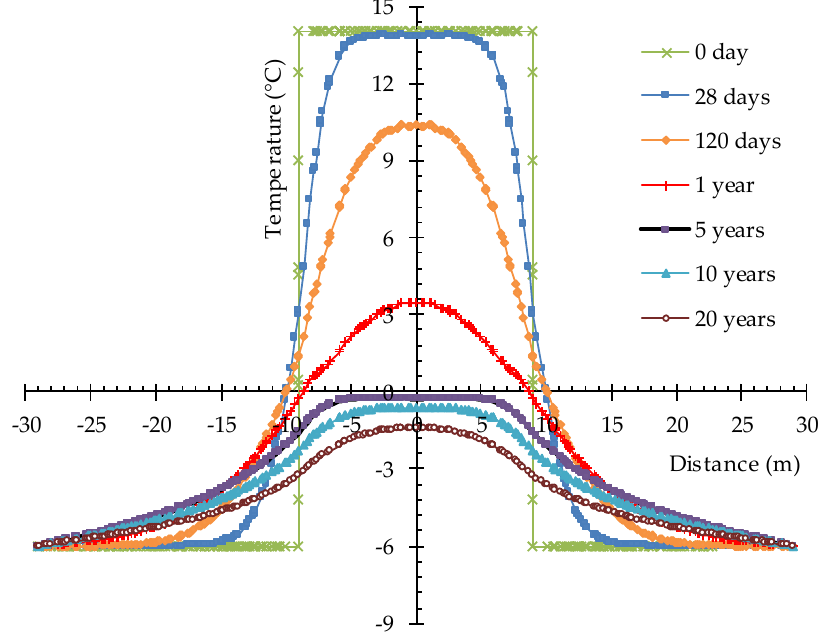
Figure 9. Transverse temperature distribution along the horizontal central axis of the simulated backfilled stope (CPB and permafrost) with curing time after CPB deposition at 14 °C for CPB and −6 °C for permafrost.